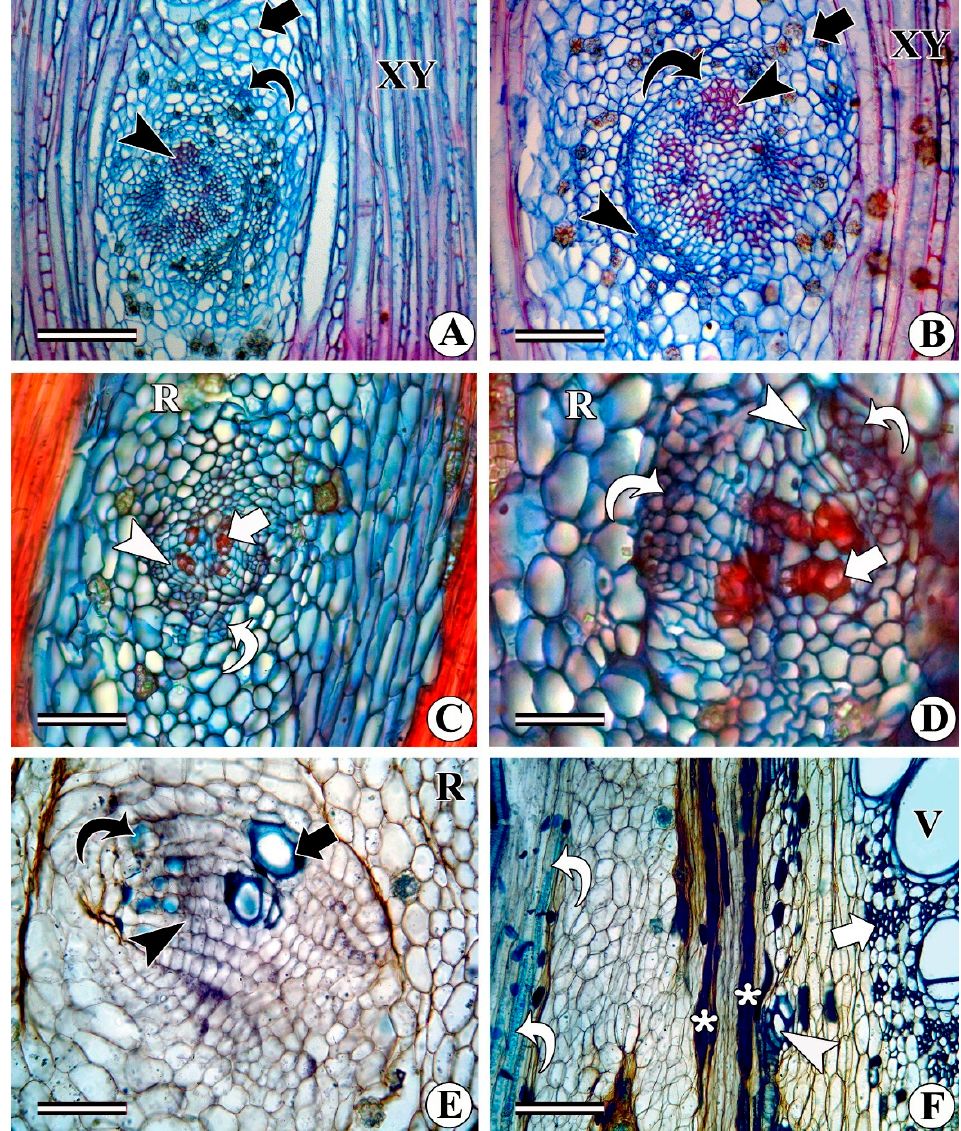
Figure 15. Tangential longitudinal ( A–E ) and transverse ( F ) views of the mature stems of different eudicots showing sieve elements in the xylem and phloem rays. ( A ) Multiseriate xylem rays (arrow) in Argyreia splendense showing meristematic centres with xylem (arrowhead) and phloem (curved arrow). ( B ) Magnified view of the multiseriate rays (arrow) in A. splendense showing meristematic activity in ray cells (curved arrow) that produced xylem and phloem (arrowheads). ( C ) Meristematic centres in one of the multiseriate rays in Hebanthe paniculata showing meristematic cells (arrowhead) and their products, i.e., xylem (arrow) and phloem (curved arrow). ( D ) Enlarged view of meristematic centre in one of the multiseriate rays in H. paniculata . Figure legend follows a similar indication. ( E ) Tangential longitudinal view of secondary phloem ray of Adansonia digitata showing meristematic centre in multiseriate ray. Arrowhead shows meristematic cells, phloem (curved arrow), and vessel element (arrow). ( F ) Meristematic centre in a multiseriate ray of A. digitata showing radial sieve elements (curved arrows) and vessels (arrowhead) and the asterisks indicate crushed phloem. Note the vessel (V) and fibres (arrow) in the transverse view of the xylem. Abbreviations : R = ray, V = vessel, XY = secondary xylem. Scale bars : A = 200 µm; B, C, F = 100 µm; D, E = 50 µm.